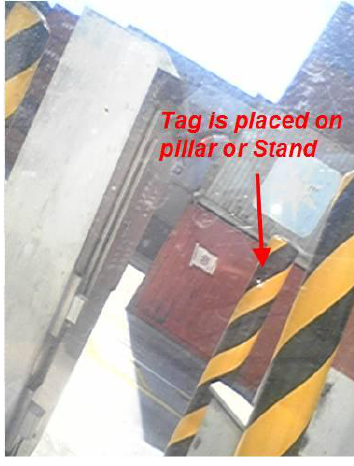
Figure 7. Tags are placed on pillar or stand at corner near